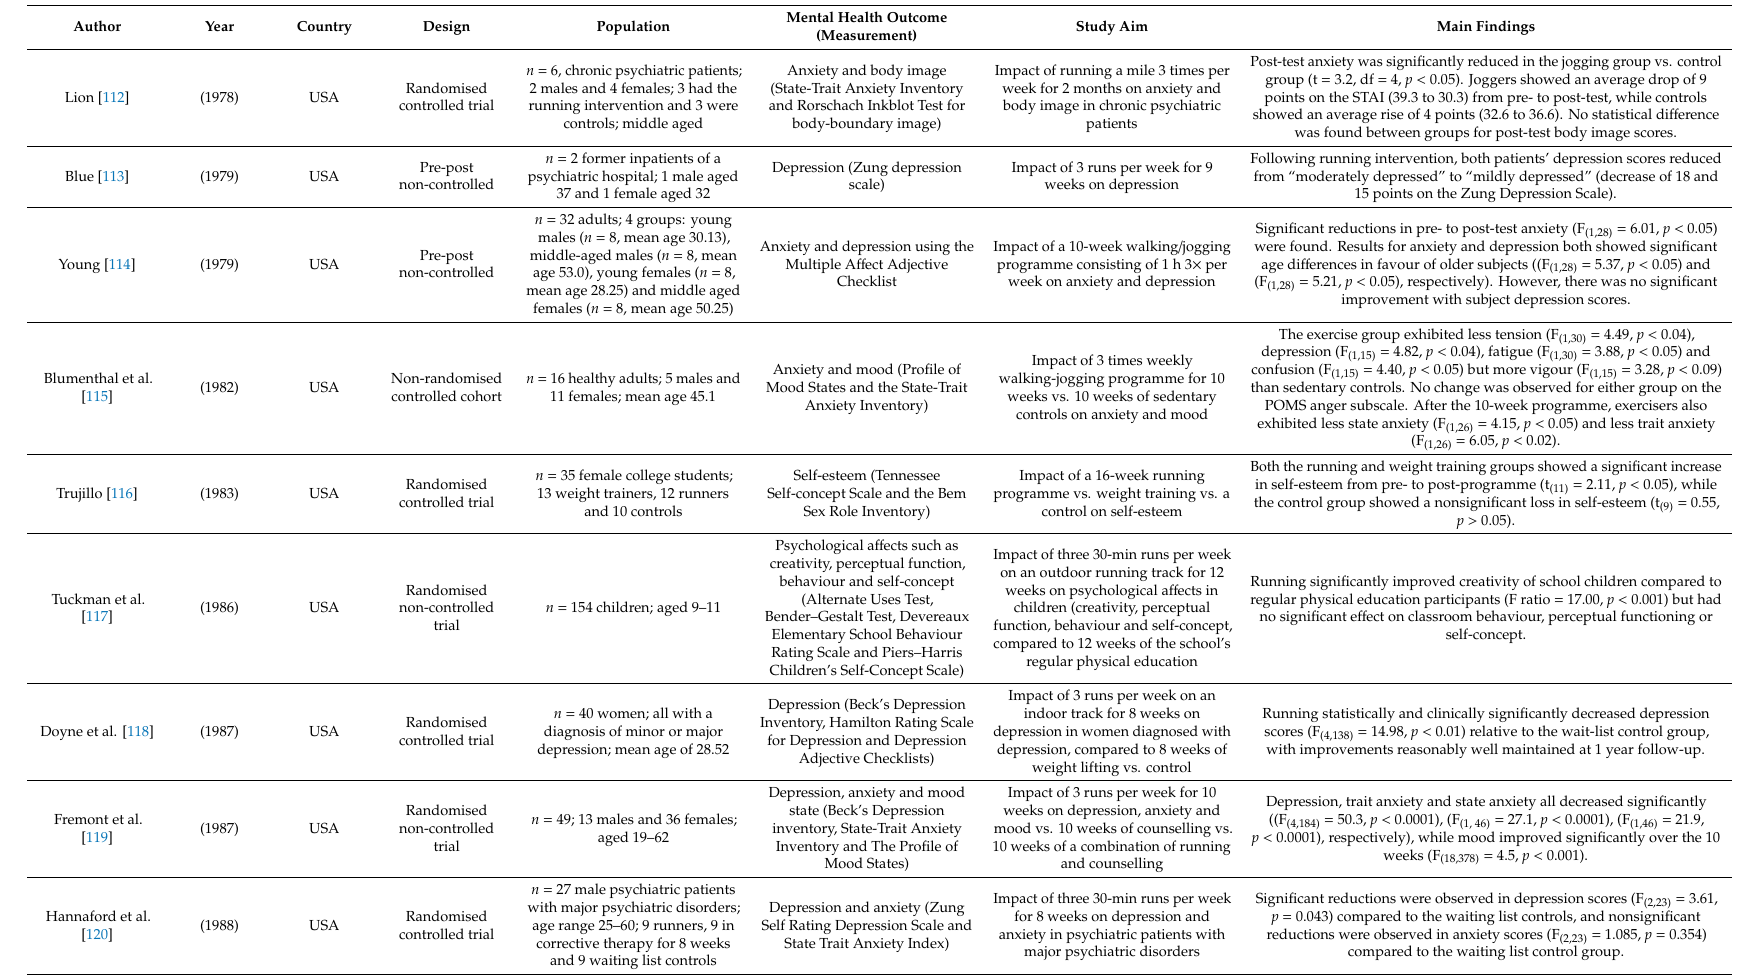
Table 6. Summary of data extraction from the 34 longer-term intervention